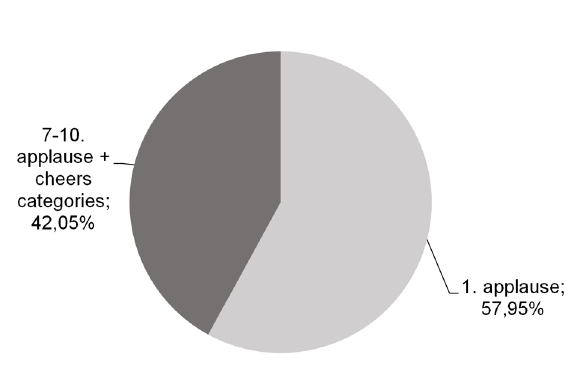
Figure 3. Collective audience responses in inauguration speeches.